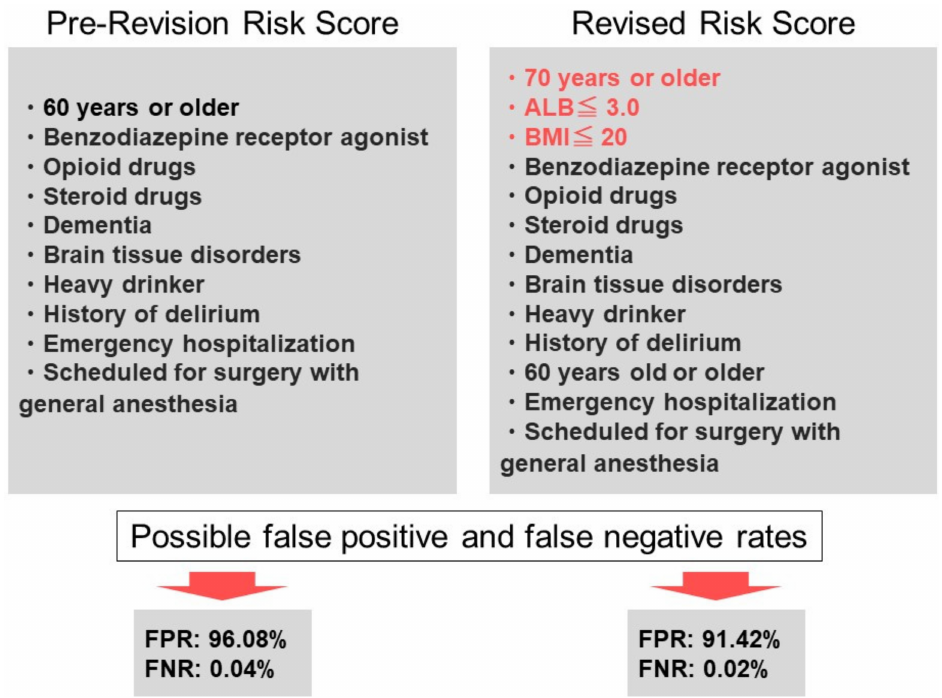
Figure 8. Risk score revision